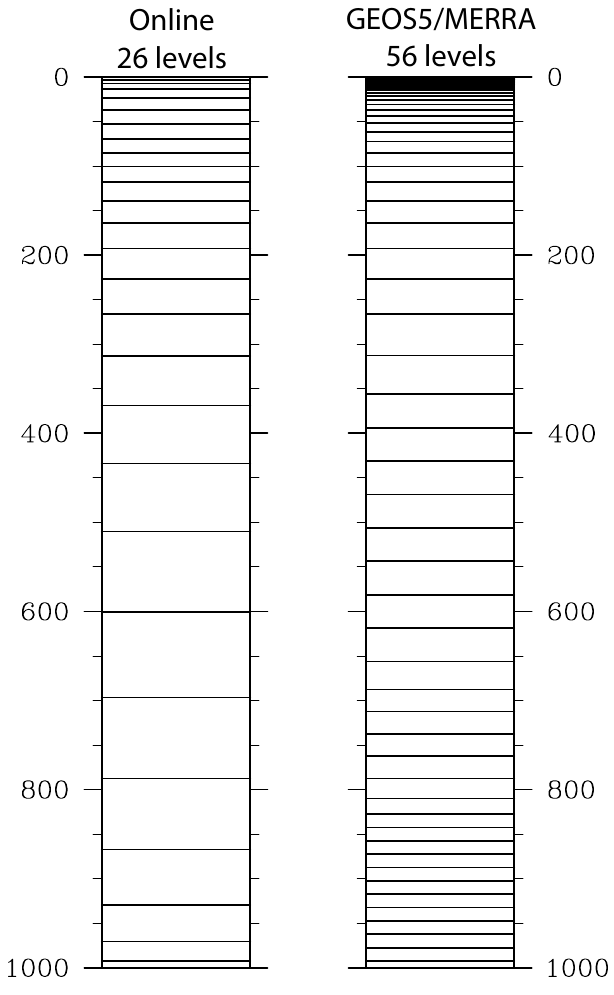
Fig. 3. Distribution of vertical levels in the various model configu-